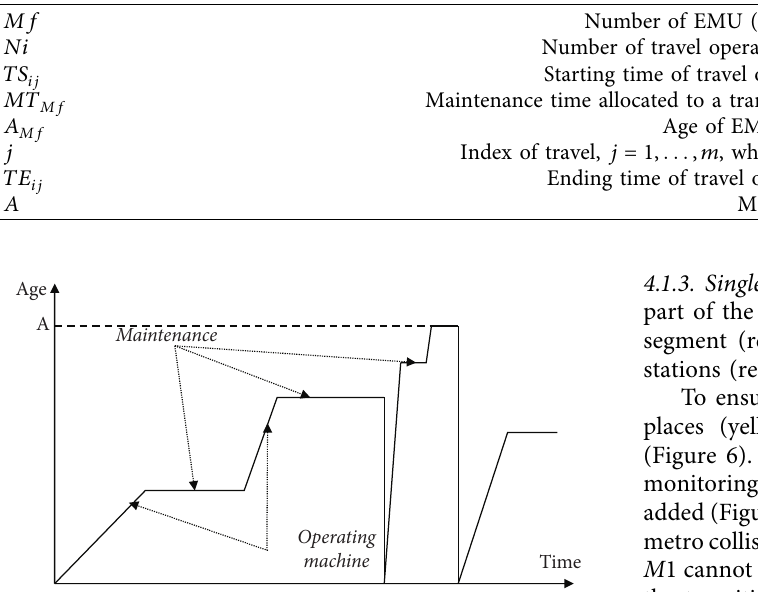
Table 1: Formulation of problem.